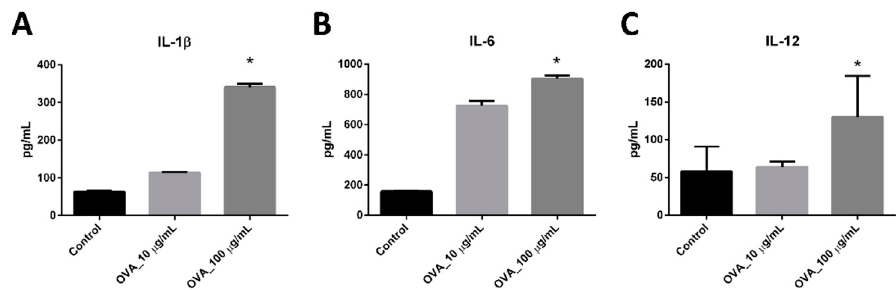
Figure 4. The cytokine production of bone marrow dendritic cell decellularized lymph node scaffolds (BMDC-dLN). BMDC-dLNs were treated with 10 or 100 µg/mL OVA antigen, and 100 µg/mL CPG-ODN for 24 h. The supernatants were collected, and an enzyme-linked immunosorbent assay was used to determine the production of cytokines ( A ) interleukin (IL) -1 β , ( B ) IL-6, and ( C ) IL-12. (Data are presented as the mean ± SD, *: p < 0.01.).